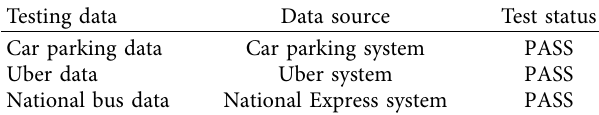
Table 7: Comparison of testing data.